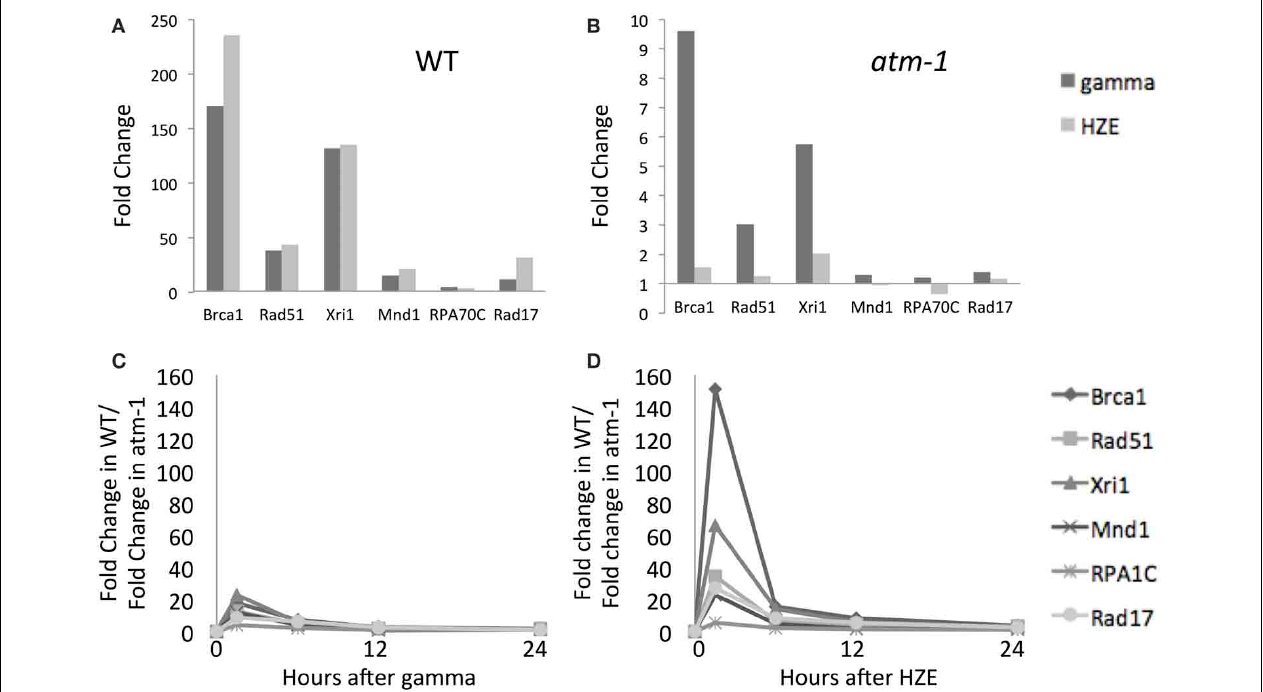
FIGURE 4 | Both gamma and HZE induce double-strand-break repair transcripts. Fold change of expression for double-strand-break repair transcripts at 1.5h after gamma radiation (dark vertical bars) or HZE (light